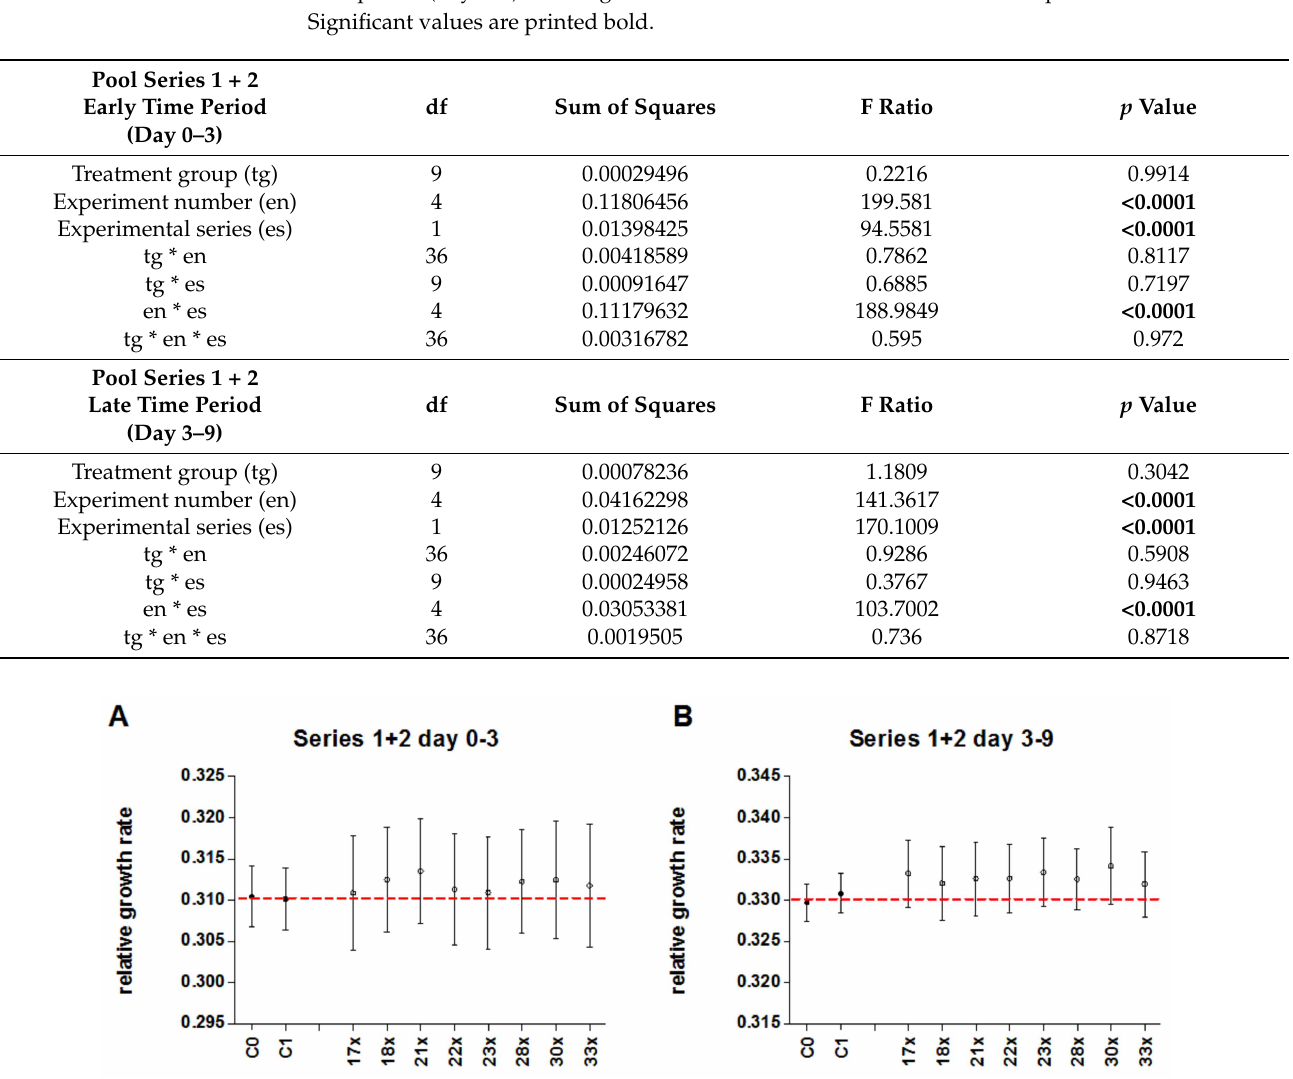
Figure 10. Mean relative growth rate ( ± 95% CI) of duckweed treated with either potentised As 2 O 3 (potency levels 17x–18x, 21x–23x, 28x, 30x, 33x, n = 50 each) or water as control (unsuccussed and succussed water samples, n = 170 each) in the 10 independent experiments of series 1 and 2. ( A ) Early time period (day 0–3), ( B ) Late time period (day 3–9). The red line represents the mean